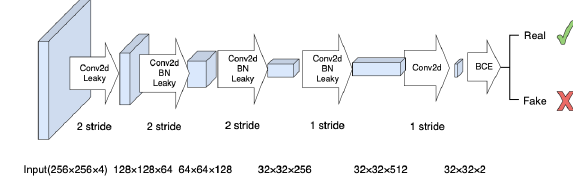
Figure 1. Illustration of PatchGAN Discriminator. The first block has no batch normalization. The first three convolutions have a filter size of 4 × 4 and stride of 2. The last two convolution layers has stride of 1, therefore retaining the spatial resolution. The output is passed on to a binary cross entropy function. The output is a score for whole image.